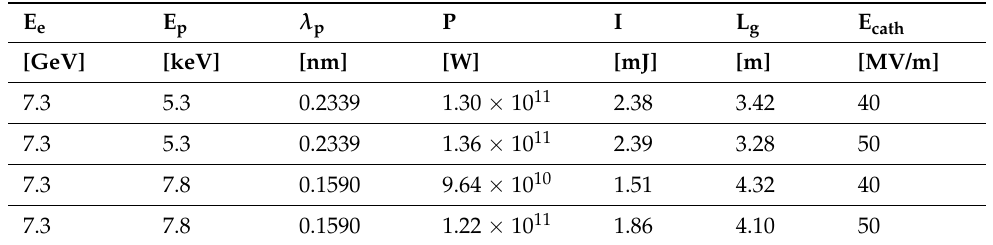
Table 3. SASE performance of 7.3 GeV electron bunches produced with cathode accelerating gradients of 40 MV/m and 50 MV/m for a potential CW mode at exemplary photon energies of 5.3 keV and 7.8 keV. The notations follow those used in Tables 1 and